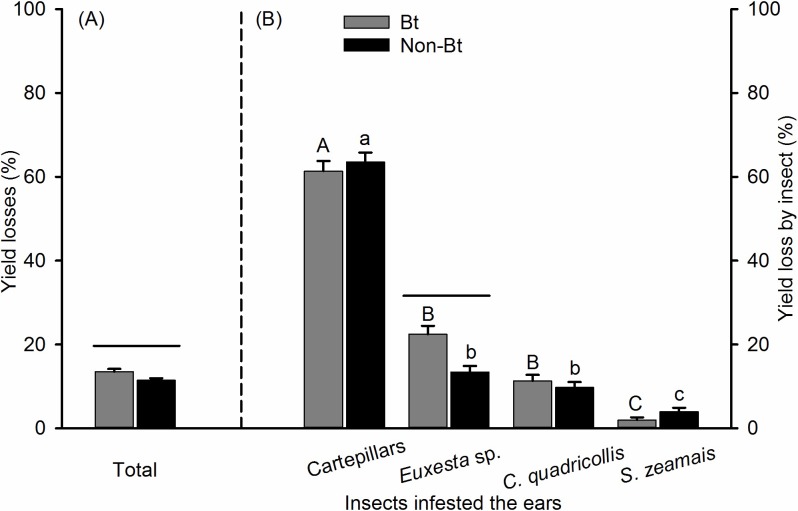
Mean losses (± SE) caused by insects in Bt and non-Bt corn in the first season of cultivation.(A) Total yield losses caused by insects, (B) yield losses caused by each insect within the total yield losses by insects. Means followed by the same letter are similar according to Dunn's test (P < 0.05); a capital letter represents grain losses of Bt corn; lowercase letters represent grain losses of non-Bt corn. A line represents a significant difference between Bt and non-Bt corn means by Mann-Whitney U-test for two groups (P < 0.05).